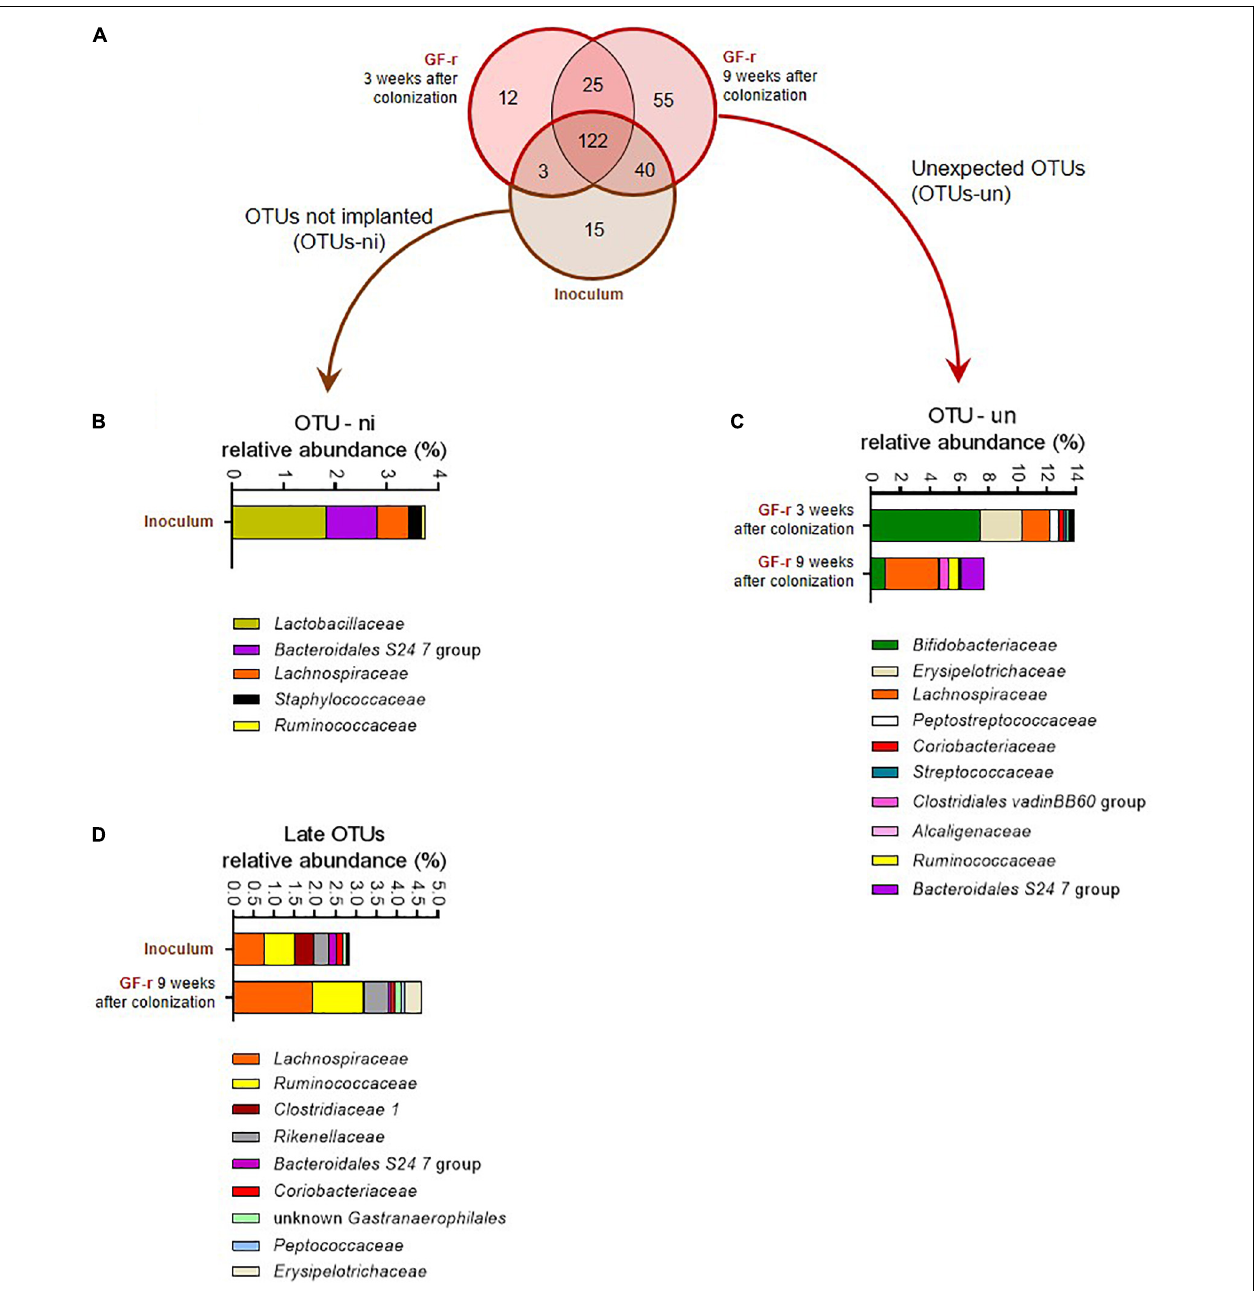
FIGURE 3 | Number and relative abundance of OTUs that did or did not successfully colonize germ-free recipient mice. (A) Venn diagram representing the overlap of OTUs in the inoculum and in GF-r mice 3 and 9 weeks after fecal microbiota transfer . (B) Relative abundance of the bacterial families corresponding to the OTUs-ni (OTUs from the inoculum that were not implanted in GF-r mice) in the inoculum. (C) Relative abundance of the bacterial families corresponding to the OTUs that were found in GF-r mice but were not detected in the inoculum (OTUs-un). (D) Relative abundance of the bacterial families corresponding to the OTUs were detected in GF-r mice feces at 9 weeks but not at 3 weeks post